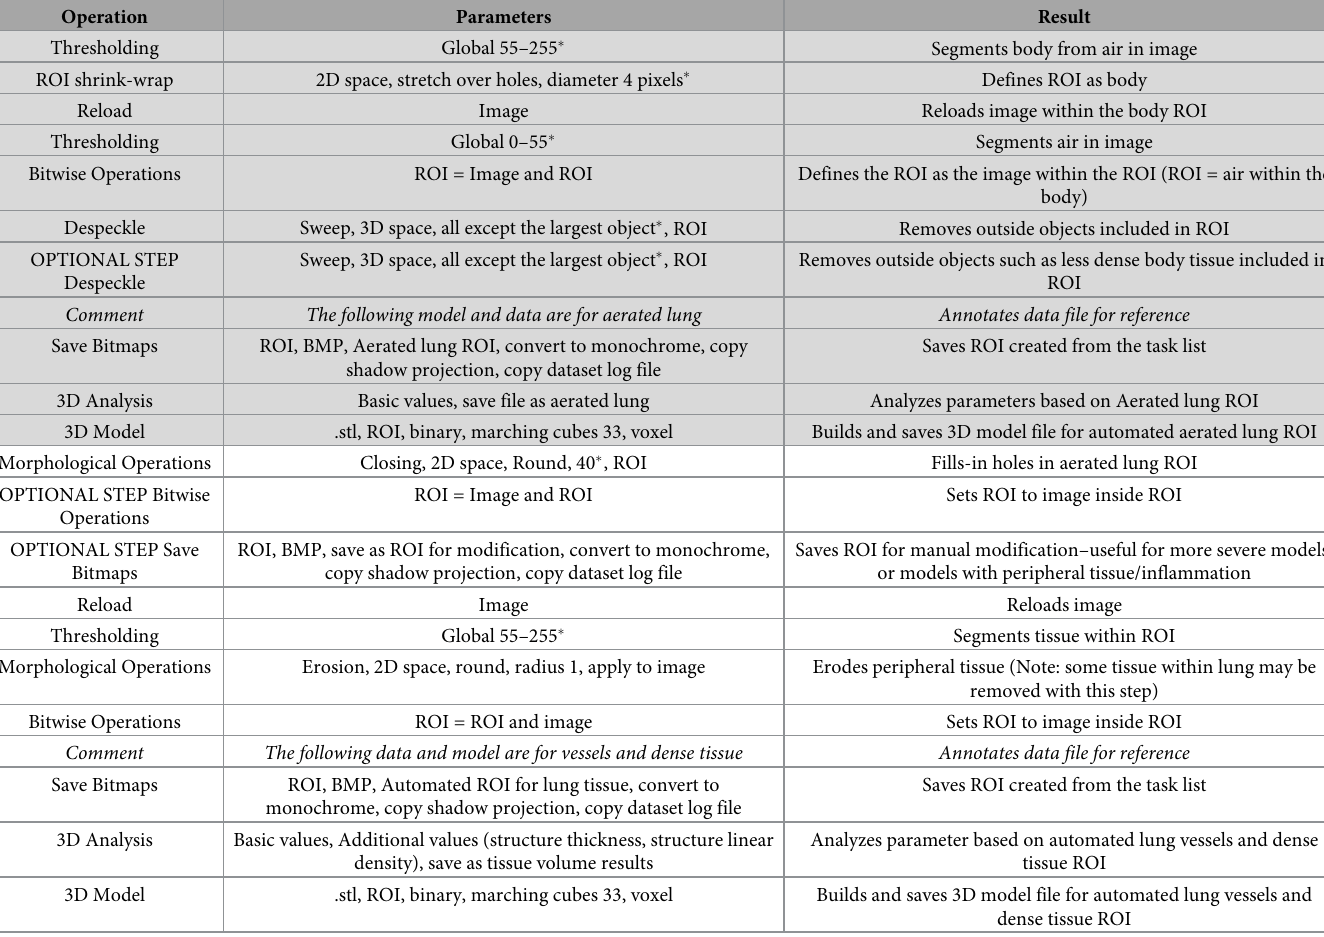
Table 1. PATS task list of operations. Operations listed use terminology for CTAn software (Bruker). Similar operations are found in other analysis software. For Amira-Avizo software (ThermoFisher): Remove island command in Amira = despeckle operation in CTAn. The lung volume was calculated with the material statistics command in Amira. Grow and shrink volume commands in Amira = morphological operation in